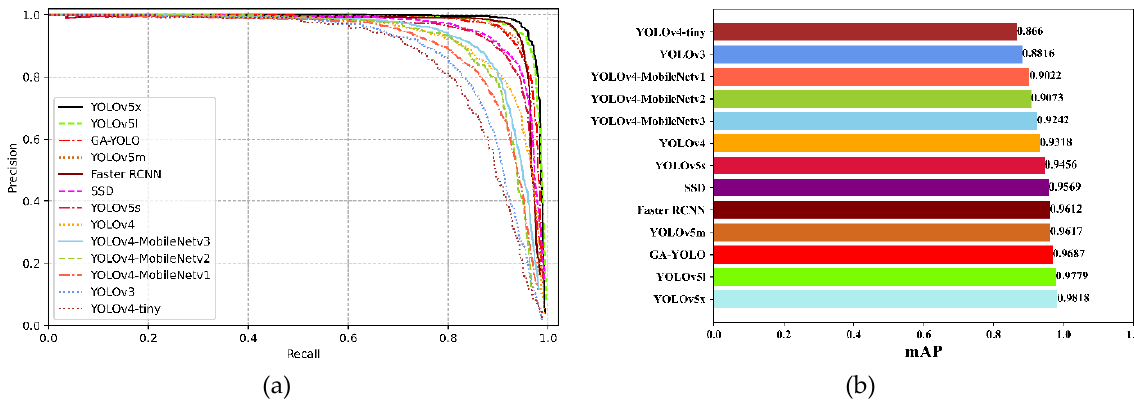
Figure 12. Experimental results ( a ) PR curve; ( b ) average precision chart. Table 9. Comparison of calculation volume, parameter volume, and weight file of different network models.